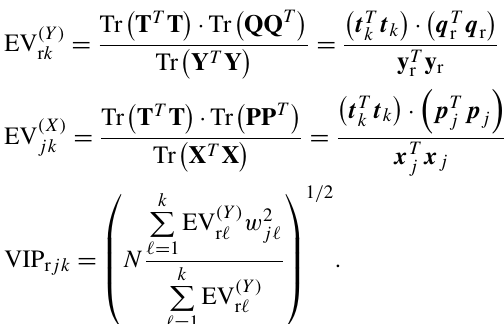
Figure specfits.pdf Plots of the fitted peaks for each